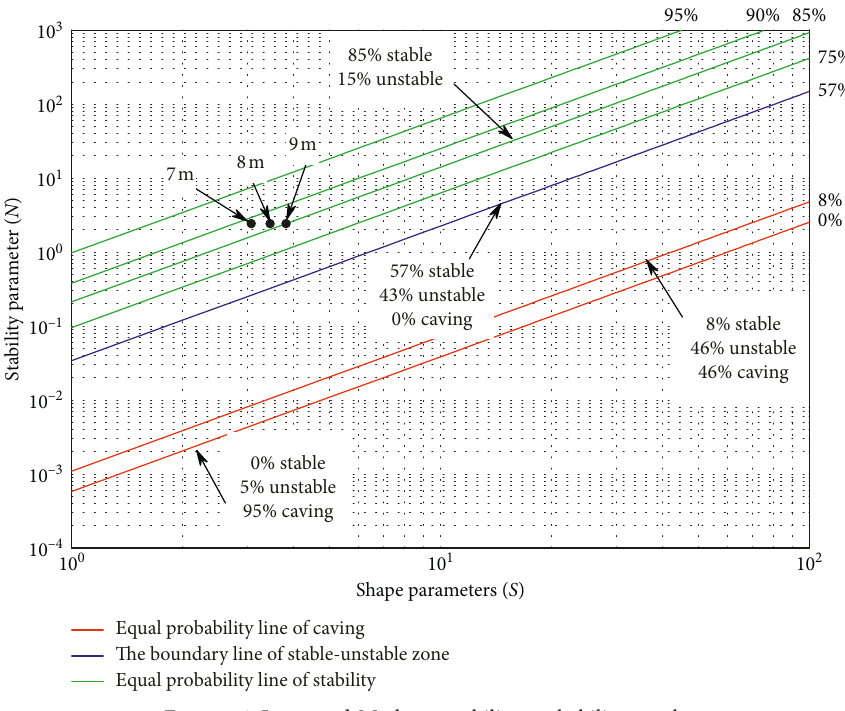
Figure 6: Improved Mathews stability probability